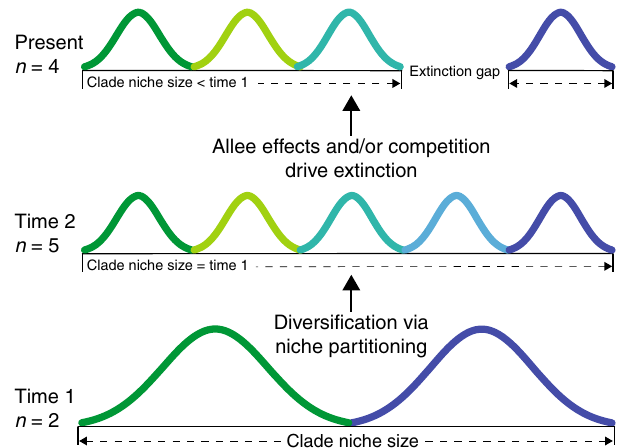
Fig. 4 Extinction driven reduction in clade niche size. Example of how niche partitioning combined with extinction associated with allee effects and/or competition, can result in a negative relationship between clade niche size and species richness as found in Fig. 3a. Different coloured curves represent species Table 1 Phylogenetic signal across the full phylogeny Niche trait λ P( λ ) P(K) Soil moist N uptake